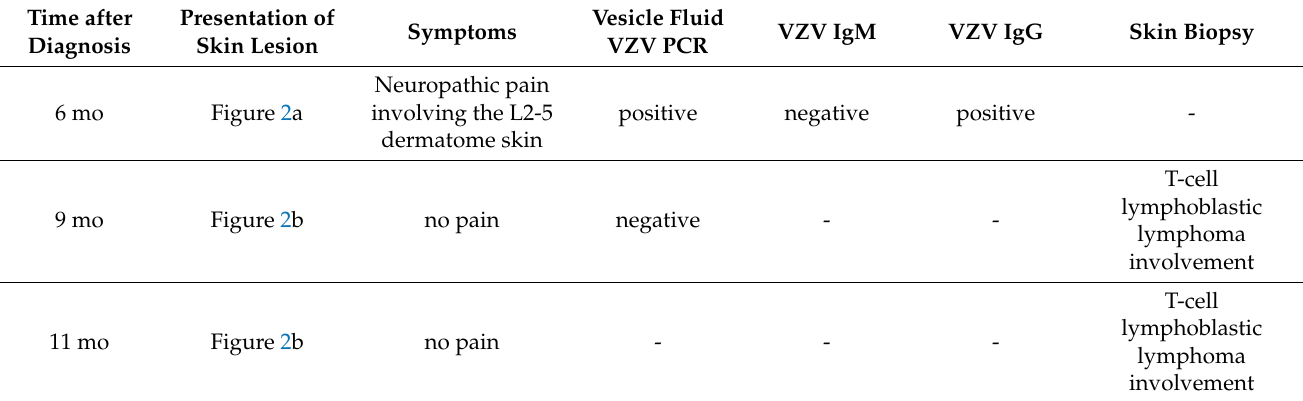
Table 1. Clinical presentation of varicella zoster lesions and lymphoma cutis lesions.